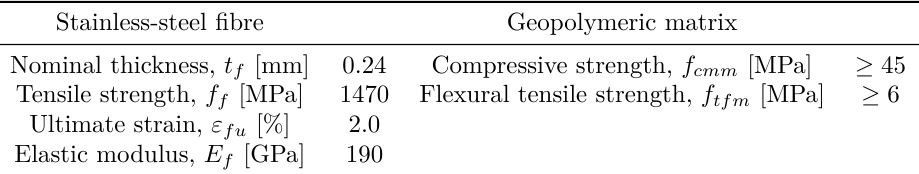
Table 4. Mechanical properties of S-FRCM